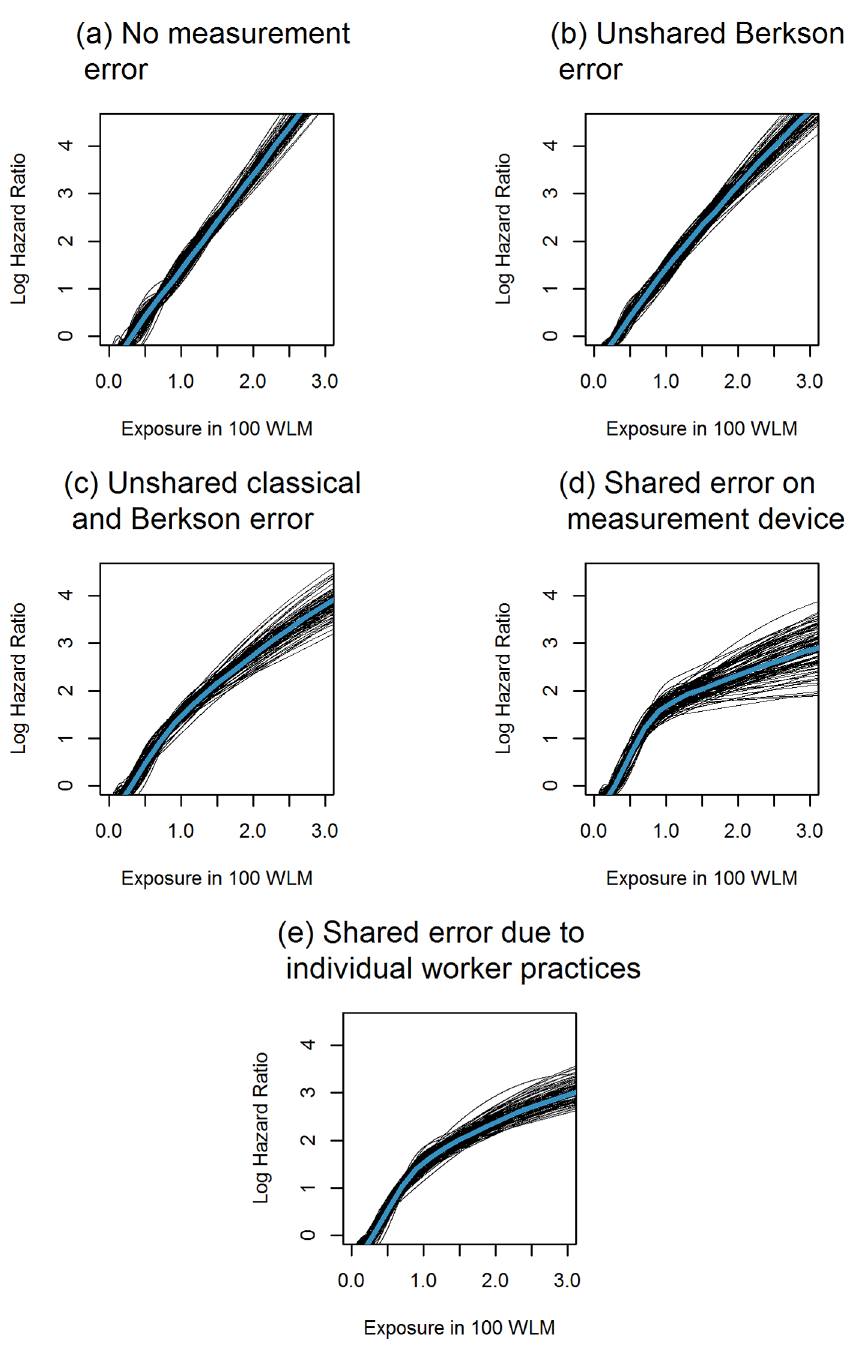
Fig 1. Estimated exposure-response curve when fitting the Cox model D based on natural cubic splines when 4 data are generated according to the Cox model D with a risk coefficient of β = 2. (a) M , i.e., no measurement 0 2 error (b) M , i.e., unshared and homoscedastic Berkson error, (c) M , i.e., unshared error of Berkson and classical 1 9 type (d) M , i.e., heteroscedastic error with a shared classical component describing the imprecision of the 10 measurement device and (e) M , i.e., heteroscedastic error with a shared Berkson component describing individual 11 worker